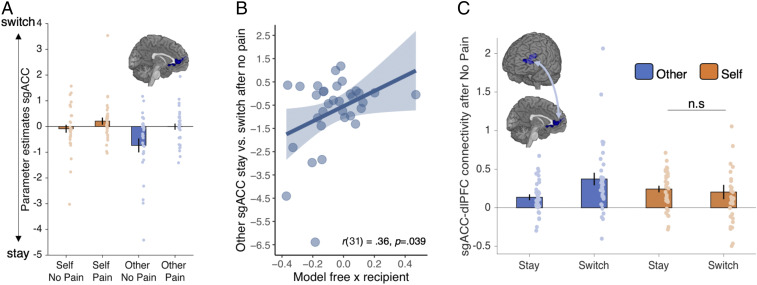
sgACC tracks stay vs. switch after no pain for other and connects more strongly to dlPFC when switching after no pain for other. (A) sgACC response (x = −2, y = 36, z = 6, K = 498, P = 0.028, FWE whole brain-corrected, after initial thresholding at P < 0.001) to stay vs. switch after no pain for other overlaid on the medial surface of an anatomical scan. The observed BOLD pattern is consistent with model-free behavior (B). Bivariate association between parameter estimates for stay vs. switch after no pain for other in sgACC and greater model-free behavior for other (more negative on x means relatively more model-free for other compared to self). (C) sgACC cluster connects to dlPFC (x = −46, y = 38, z = 26, k = 382, Z = 4.12, P = 0.039, FWE whole brain-corrected after initial thresholding at P < 0.001) during decisions to switch relative to stay after no pain for other. Average slope estimates across participants show stronger connectivity during switch decisions than stay decisions after receiving no pain for other (blue bars) but no difference in sgACC–dlPFC connectivity between stay and switch for self [t(32) = 0.43, P = 0.667, d = 0.08, 95% CI for Cohen’s d = −0.27 0.42; BF01 = 4.92 providing substantial evidence in support of the null] (orange bars). n.s, not statistically significant.